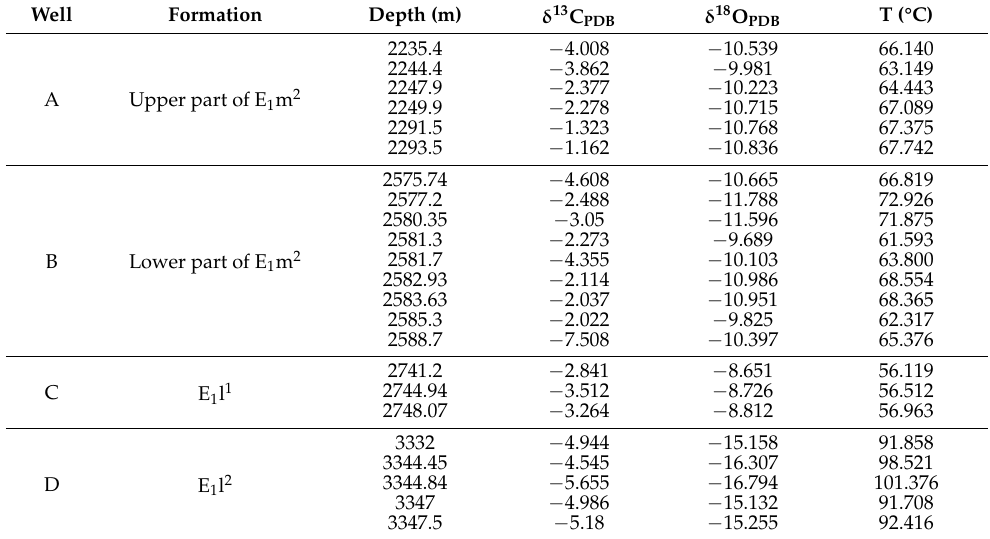
Table 3. The test data of the whole rock carbon and oxygen stable isotopes of sandstone in the West Lishui Sag (according to Shanghai Branch Company of